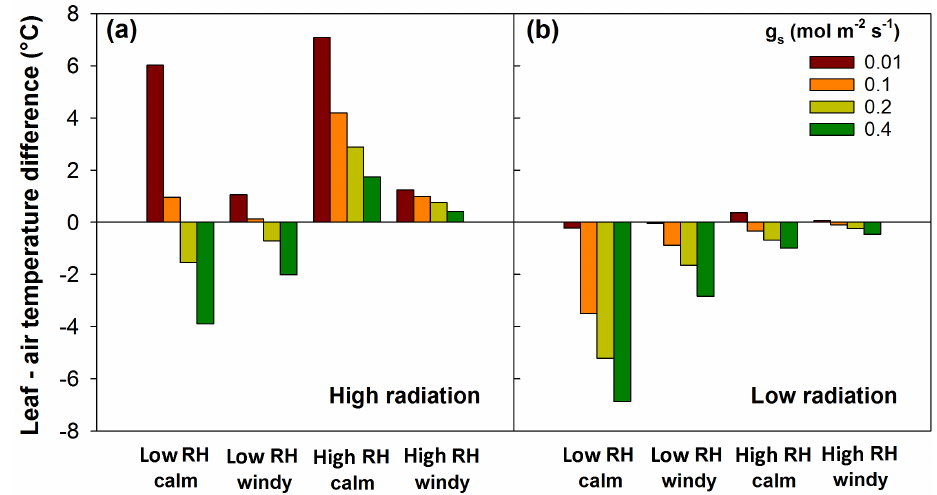
Figure 1. Modelled leaf-to-air temperature difference depending on type of heat wave and stomatal conductance ( g s ) . Type of heat wave: high (a) or low (b) incident shortwave radiation (800 or 100Wm − 2 ) , high or low relative humidity of the air (RH = 0.90 or 0.45), and calm or windy weather (wind speed = 0.1 or 6ms − 1 ) . Air temperature was set to 40 ◦ C in all simulations, and leaf width to